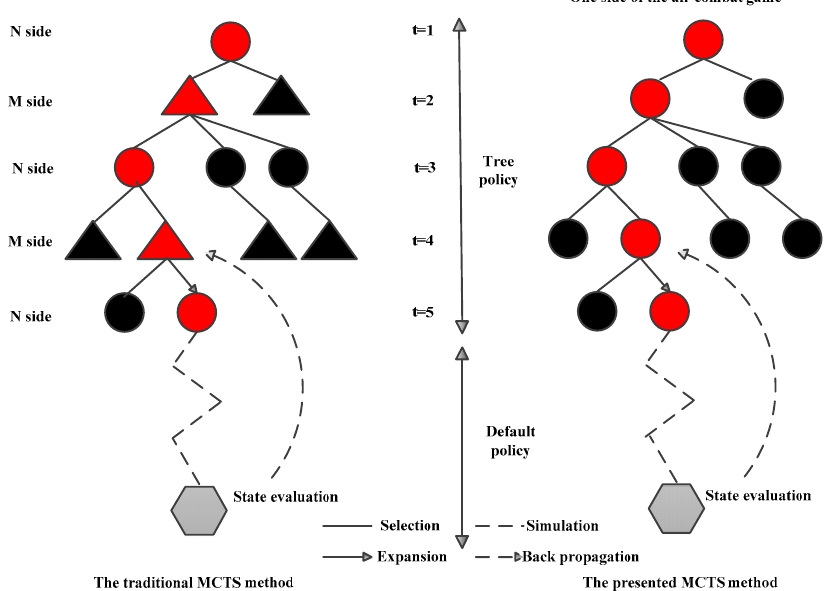
Figure 3. Diagram of the MCTS iterative process.